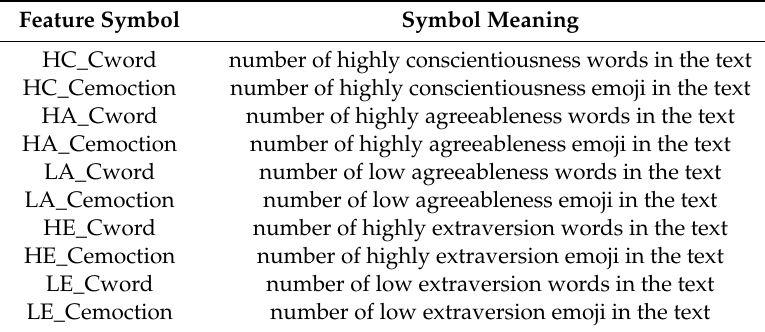
Table 1. Text characteristics of a personality prediction.